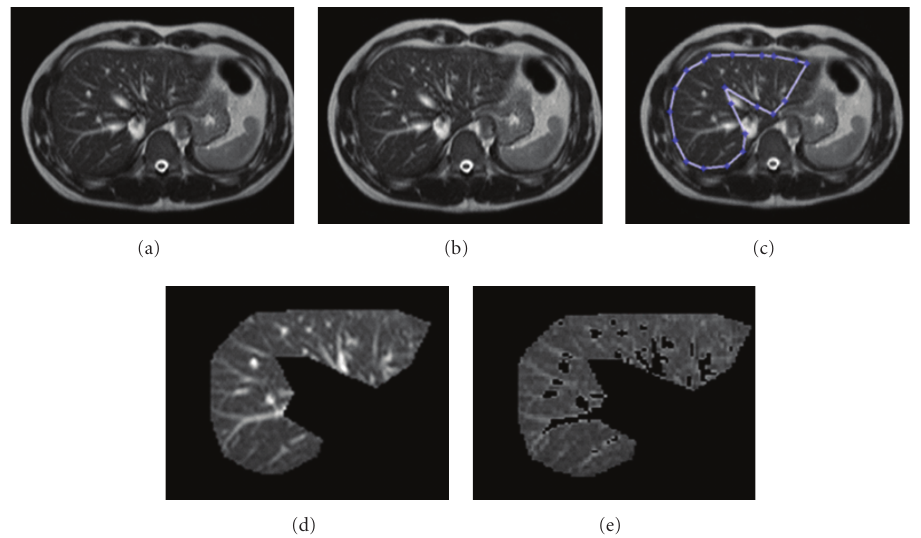
Figure 1: (a) MRI T2-weighted image (original scale), (b) MRI T2-weighted image on altered scale, (c) selected ROI of liver, (d) magnified ROI of liver, and (e) magnified ROI of liver after filtering out of artery and portal veins using Otsu’s algorithm.